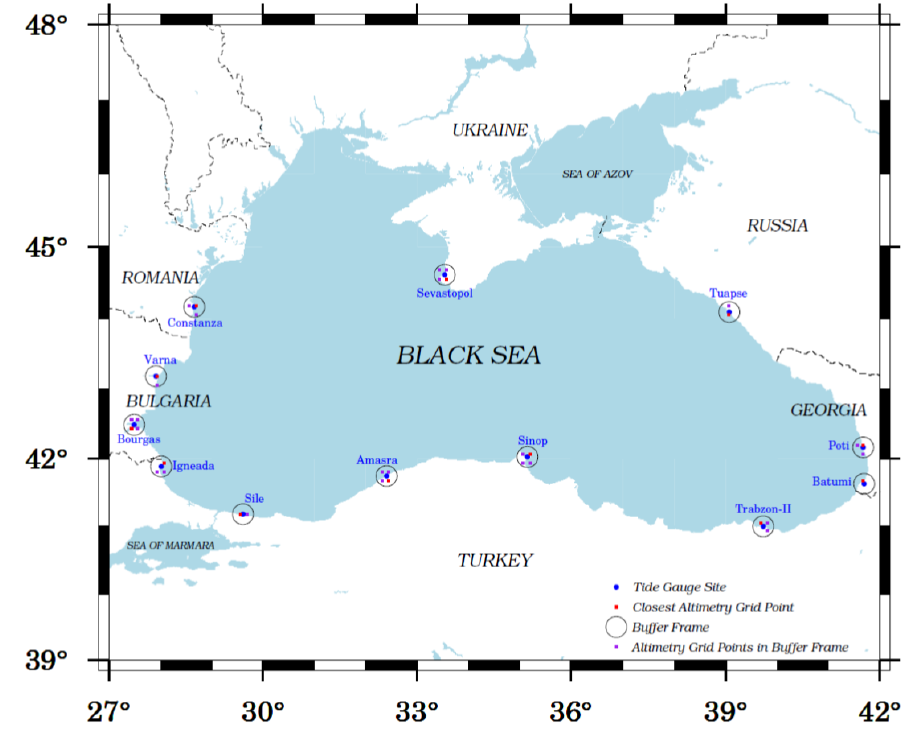
Figure 1. Data locations used in the